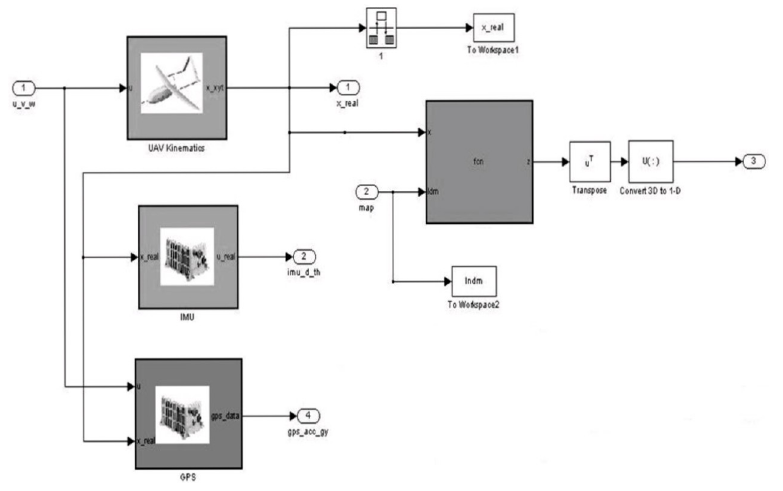
Fig 5. UAV simulation